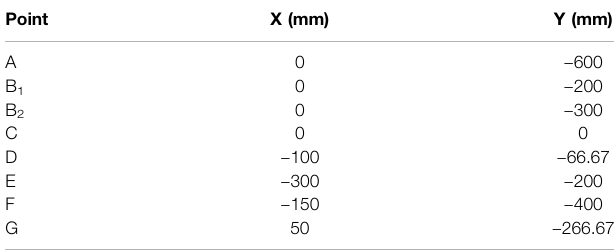
TABLE 2 | Coordinates of the axes, input and output points of the pantograph mechanism.